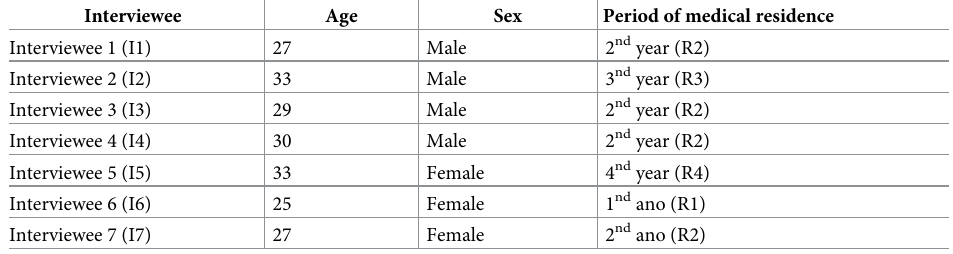
Table 1. Characterization of respondents according to age, sex and period of medical residency. Interviewee